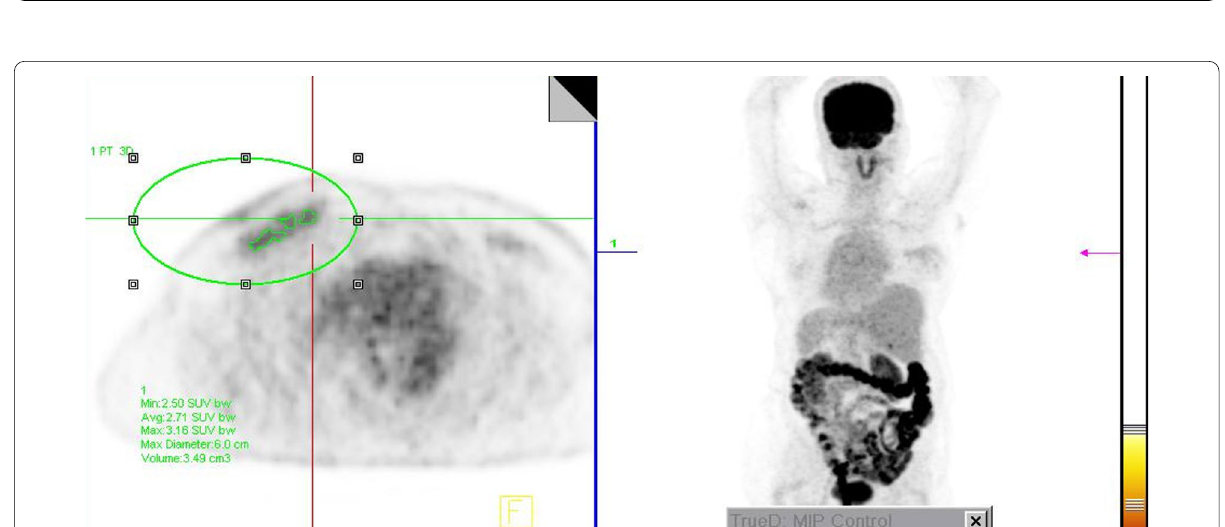
Fig. 3 Forty-nine-year-old female, history of left mastectomy with suspected recurrent tumor in the right breast. Biopsy revealed benign lesion fibroadenoma. Left: axial PET showing FDG intensity of lesion lower than that of the mediastinal blood pool. Right: fused 18 F FDG PET revealed the correlated SUVmax: 2.77